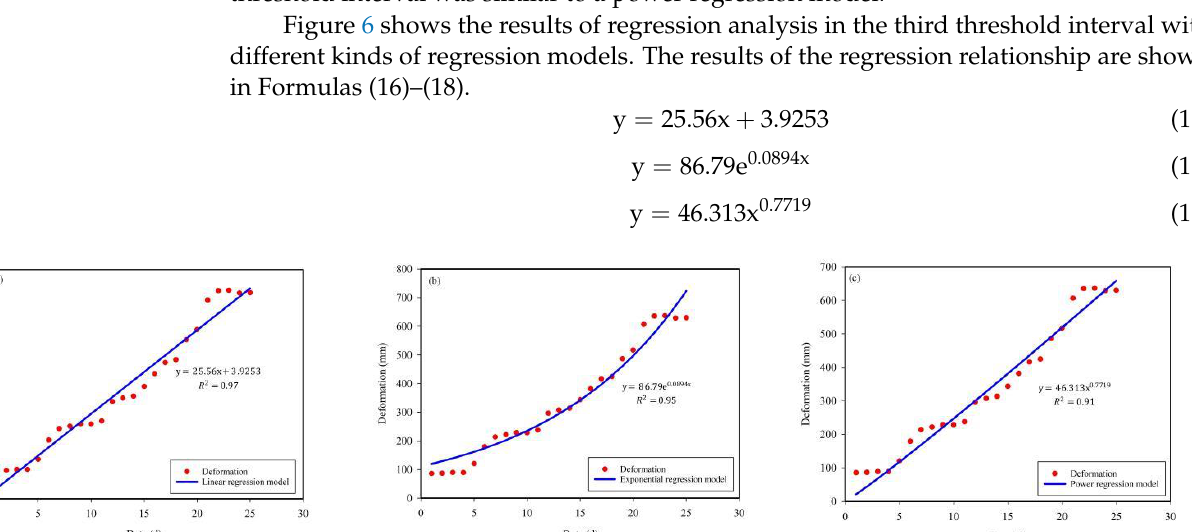
Figure 6. The results of regression analysis in the third threshold interval with different regression models. ( a ) Linear regression model; ( b ) exponential regression model; ( c ) power regression model.